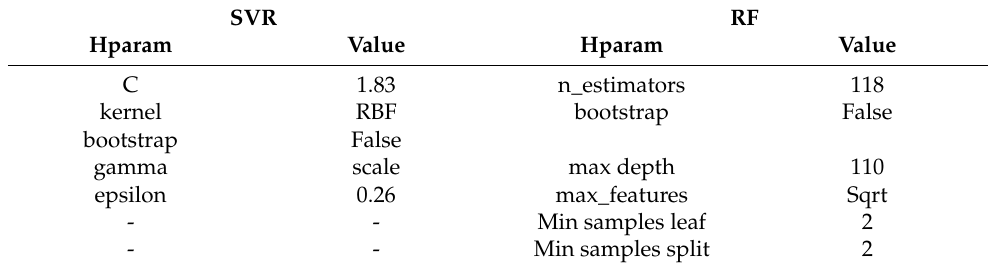
Table 8. Hyperparameters selected for RF and SVR using random grid